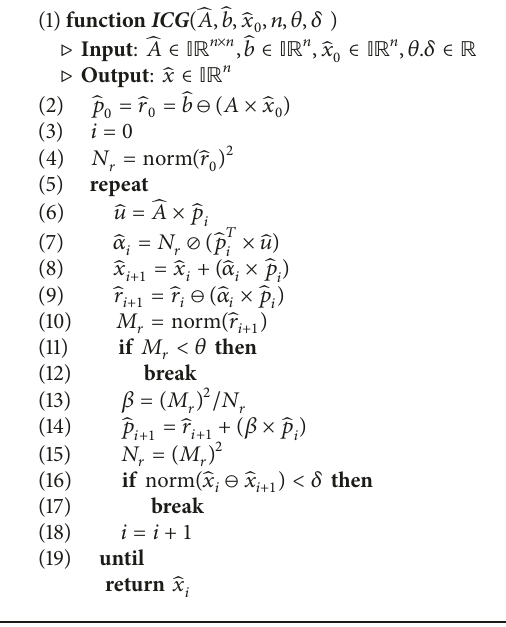
Algorithm 2: Interval modified conjugate gradient